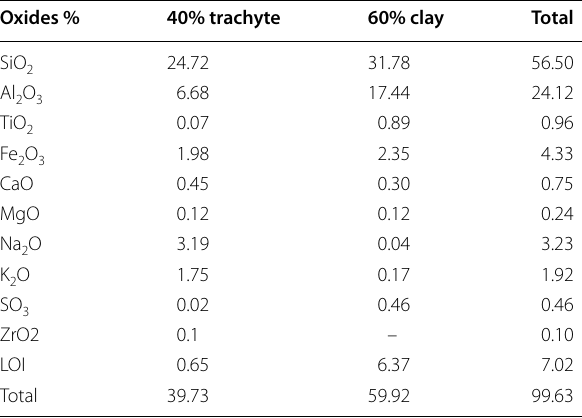
Table 3 Chemical composition of the design batch no. 2